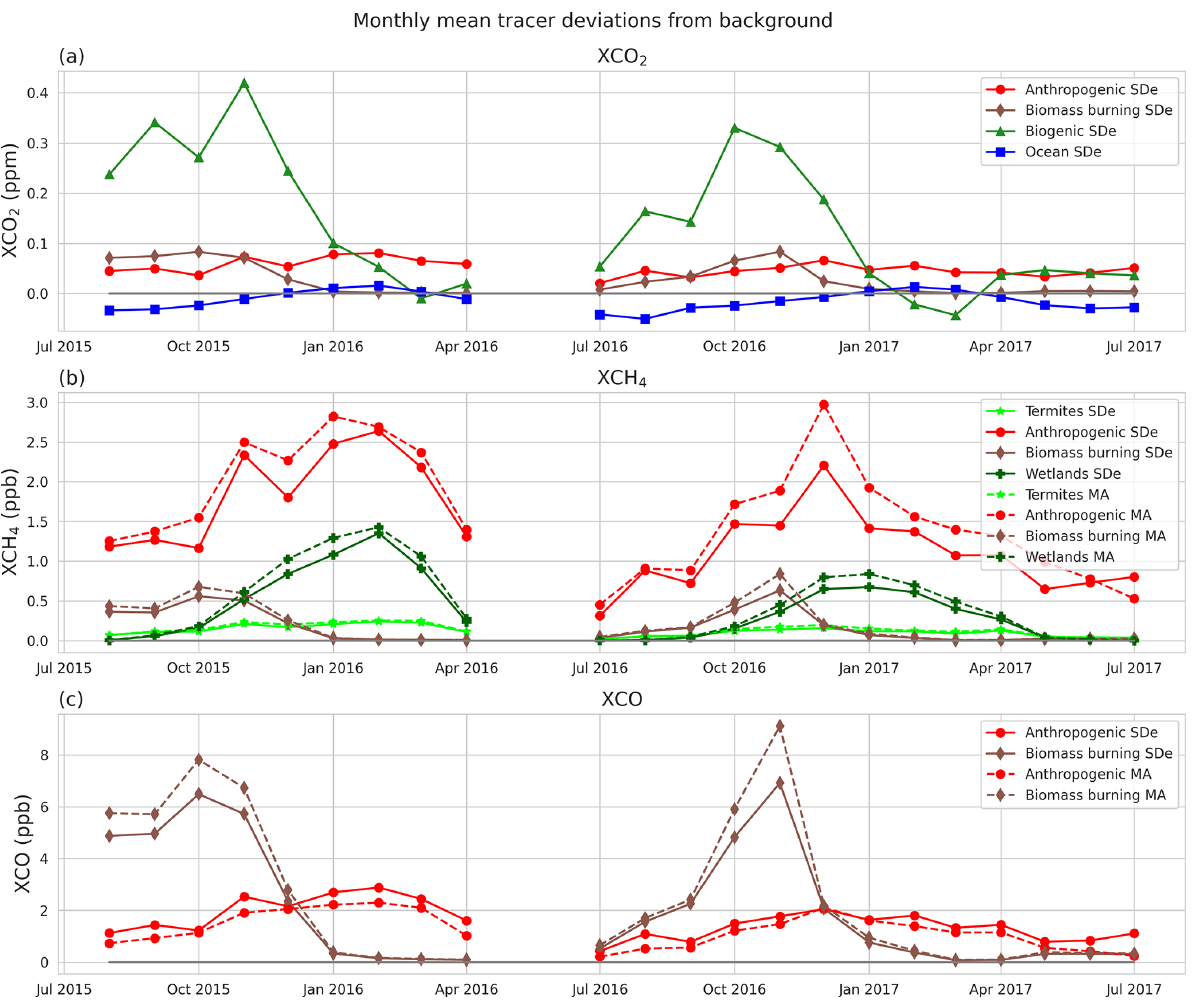
Figure 11. Monthly mean tracer contributions to the column-averaged mole fractions of (a) CO 2 , (b) CO, and (c) CH 4 . The different colors represent different tracers, i.e., anthropogenic (red), biogenic (green), ocean (blue), wetlands (dark green), termites (light green), or biomass burning (brown). The solid lines are the mean monthly contributions at SDe, while the dashed lines are for MA.